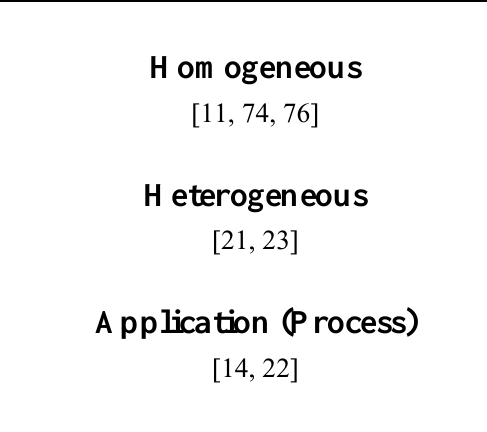
Table 3. Classifications for Mashup